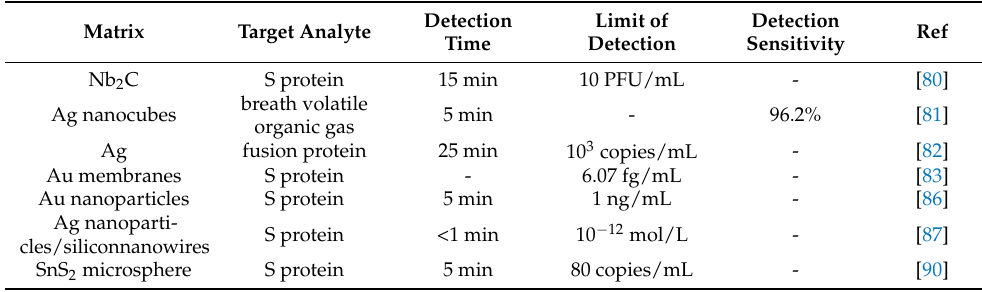
Table 2. Some key parameters of the reported SERS biosensors for SARS-CoV-2 detection. Matrix Target